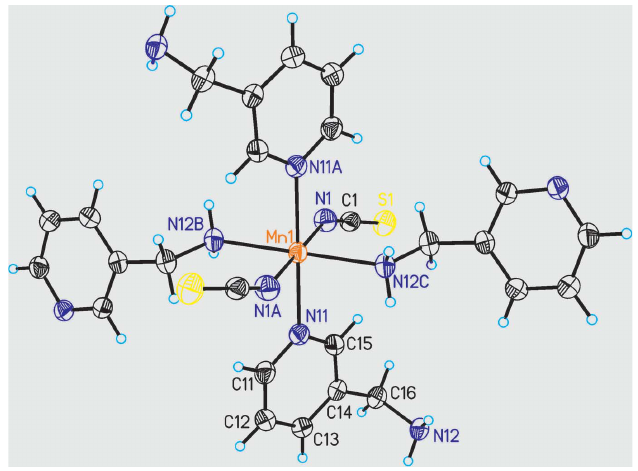
Figure 1 The coordination of the Mn II cation in the title compound with displacement ellipsoids drawn at the 50% probability level. [Symmetry codes: (A) (cid:3) x , (cid:3) y + 1, (cid:3) z , (B) 1 (cid:3) 1 + z .] 2